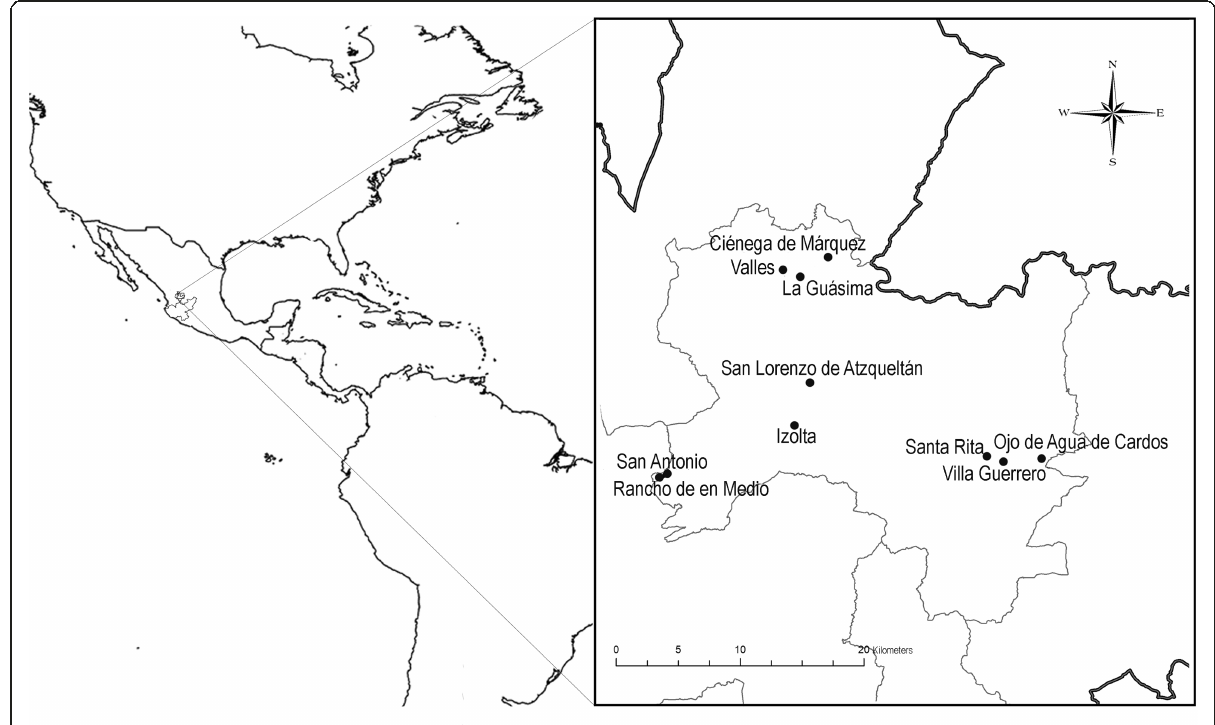
Fig. 1 Map showing the communities where interviews were performed and mushrooms were